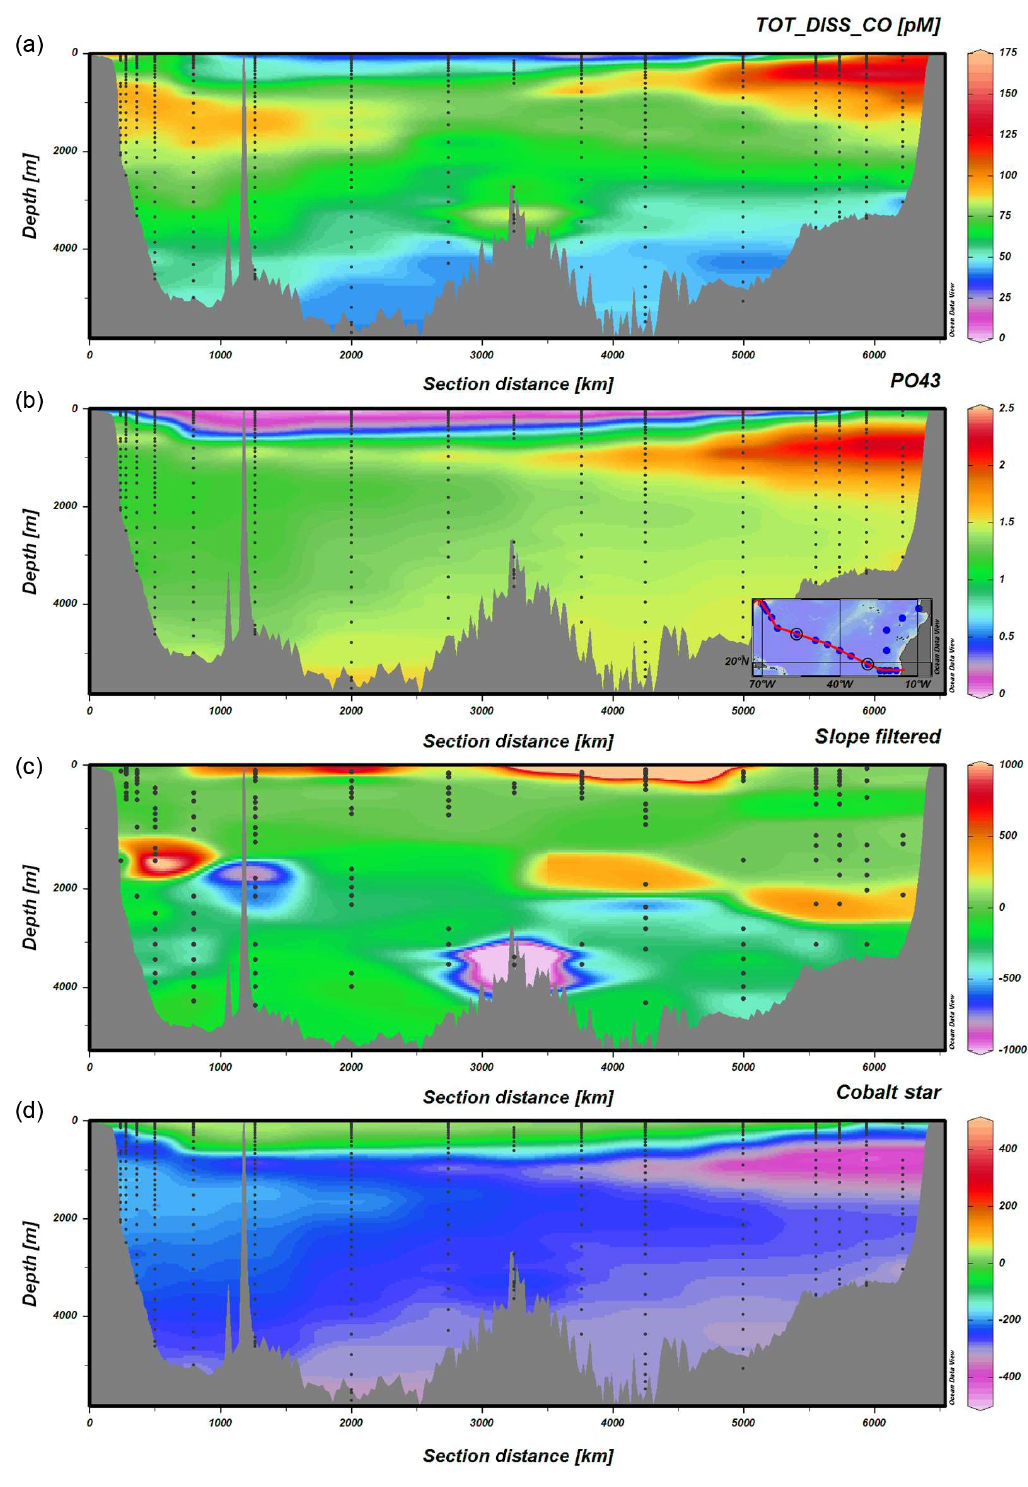
Figure 14. Comparison of derived variables related to dissolved cobalt and phosphorus inventories in the zonal portion of the US North Atlantic transect (GA03). Ocean sections of (a) dissolved cobalt (pM), (b) phosphate (µM), (c) dCo:P slopes ( r ≥ | 0 . 7 | ), and (d) Co* (with a Co:P stoichiometry of 237µmolmol − 1 based on the aggregate p Co: p P ratio in the upper